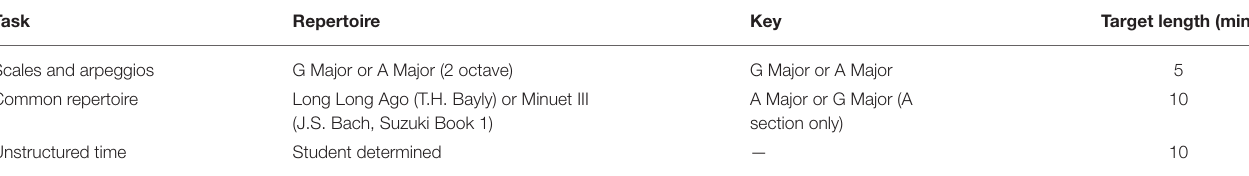
TABLE 1 | Structure of study lessons split into sections with task, repertoire, key, and time spent within a lesson section.